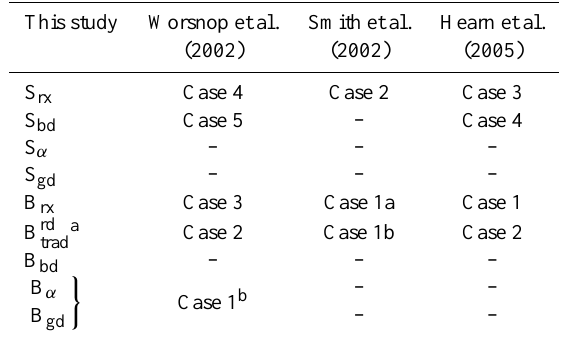
Table 5. Comparison of limiting cases proposed in this study to cases of the oleic acid–ozone system in previous studies. A “–” sym- bol indicates no relationship. The numberings refer to the nomen- clature in the original publications.